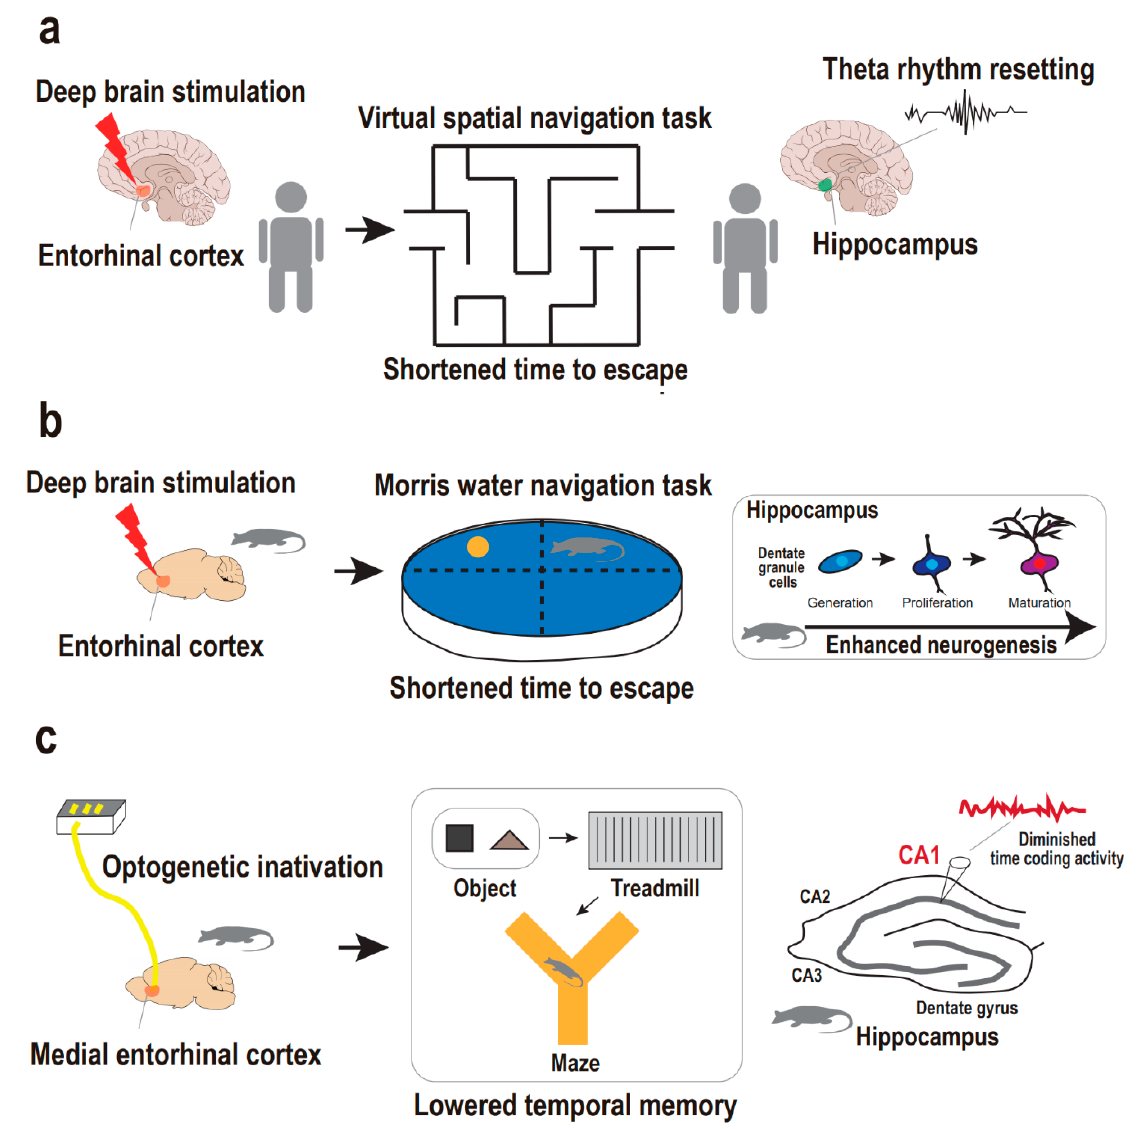
Figure 2. Supportive findings for entorhinal cortex-regulated hippocampal neurogenesis in the regulation of memory. ( a ) Entorhinal–hippocampal circuitry and hippocampal theta rhythm resetting in the regulation of human spatial memory. Deep brain stimulation on entorhinal cortex results in hippocampal theta rhythm resetting, which is accompanied with a shortened time to escape from a maze in the spatial navigation task in humans. ( b ) Entorhinal–hippocampal circuitry and neurogenesis in the regulation of animal spatial memory. Deep brain stimulation on entorhinal cortex results in enhanced neurogenesis, which is accompanied with a shortened time to escape in the Morris water navigation task in mice. ( c ) Entorhinal–hippocampal circuitry and hippocampal CA1 coding in the regulation of animal temporal memory. Optogenetic inactivation of the medial entorhinal cortex results in disruption in hippocampal CA1 coding activity, which is accompanied by the diminished temporal memory in the sequential object–treadmill–maze task in rats.